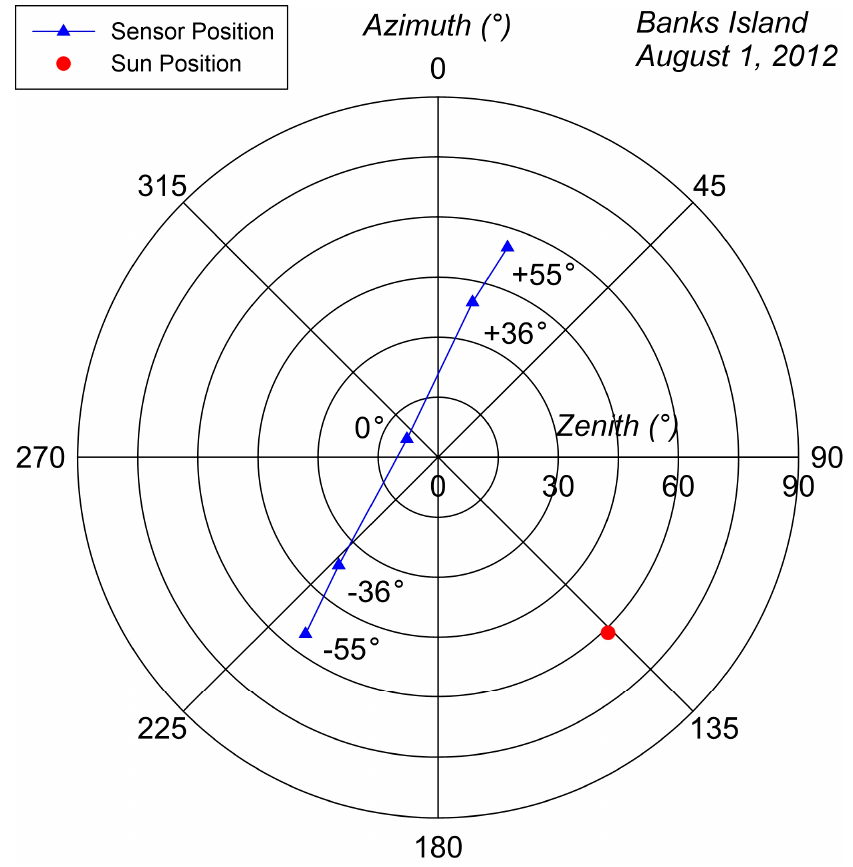
Figure 2. Polar plot showing the acquisition angles (i.e., forward and backscatter) for Banks Island (1 August 2012). The acquisitions represented here were typical of each site. Geometric correction (orthorectification) was implemented in Geomatica OrthoEngine (PCI Geomatics, 2016) using Toutin’s rigorous model [89–92]. Nadir imagery was the most accurately rectified with an average x, y positional error of approximately ~13.05 m. The most extreme VZAs produced the greatest degree of positional error; for example − 55 ◦ had a mean positional error of ~21.62 m. Imagery for Banks Island, which is relatively flat, produced a mean positional error of 10.58 m, whereas the Richardson Mountains (2013 and 2014) images produced positional accuracies of ~22.46 m and ~21.44 m, respectively. Despite these variations, all orthorectified images had sub-pixel accuracy. Finally, spectra from the processed surface reflectance images were extracted at each field plot and com- pared to the ground-level spectral measurements to determine the spectral fidelity and accuracy of the spaceborne measurements using cross-correlation